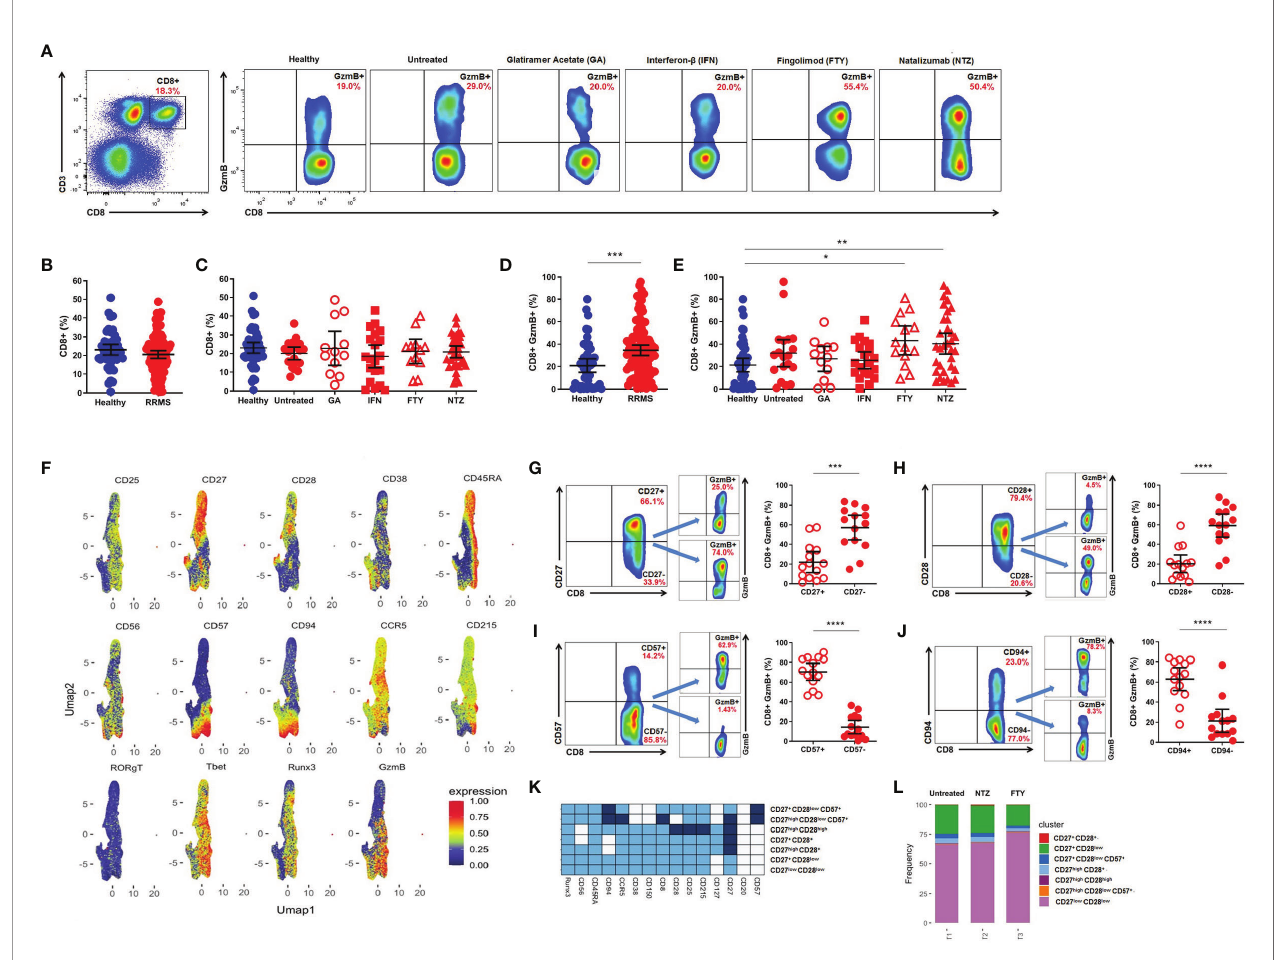
FIGURE 1 | Cytotoxic CD8 + T lymphocytes in relapsing-remitting multiple sclerosis (RRMS) patients. (A) Gate strategy for total CD8 + and CD8 + GzmB + T lymphocytes from healthy donors, untreated RRMS, and treated [Glatiramer Acetate (GA), Interferon- b (IFN), Fingolimod (FTY), and Natalizumab (NTZ)] RRMS patients. (B) Proportion (%) of total CD8 + T lymphocytes in healthy donors (blue) and RRMS patients (red). (C) Proportion (%) of CD8 + T lymphocytes in healthy donors (blue), untreated RRMS (red), and treated RRMS patients (GA, IFN, FTY, NTZ) (red). (D) Proportion (%) of circulating CD8 + GzmB + T lymphocytes in healthy donors (blue) and RRMS patients (red). (E) Proportion (%) of circulating CD8 + GzmB + T lymphocytes in healthy donors (blue), untreated RRMS (red), and treated RRMS patients (GA, IFN, FTY, NTZ) (red). Bars represent mean values. Each column represents mean (95% CI). * p < 0.05; ** p < 0.01; *** p < 0.001; **** p < 0.0001. (F) Uniform Manifold Approximation and Projection (UMAP) gated in CD3 + CD8 + T lymphocytes from RRMS patients with different conditions non-identi fi ed and based on the Arcsinh-transformed expression of the markers. Gate strategy and proportion (%) of granzyme B (GzmB) derived from circulating (G) CD8 + CD27 + vs. CD8 + CD27 - , (H) CD8 + CD28 + vs. CD8 + CD28 - , (I) CD8 + CD57 + vs. CD8 + CD57 - , (J) CD8 + CD94 + vs. CD8 + CD94 - T lymphocytes in RRMS patients (red). Bars represent mean values. Each column represents mean (95% CI). *p < 0.05; ** p < 0.01; *** p < 0.001; **** p < 0.0001. (K) Heatmap of the expression of the markers in subpopulations manually identi fi ed in CD3 + CD8 + T lymphocytes from RRMS patients. (L) Barplot representing the frequency of each subpopulation in CD3 + CD8 + T